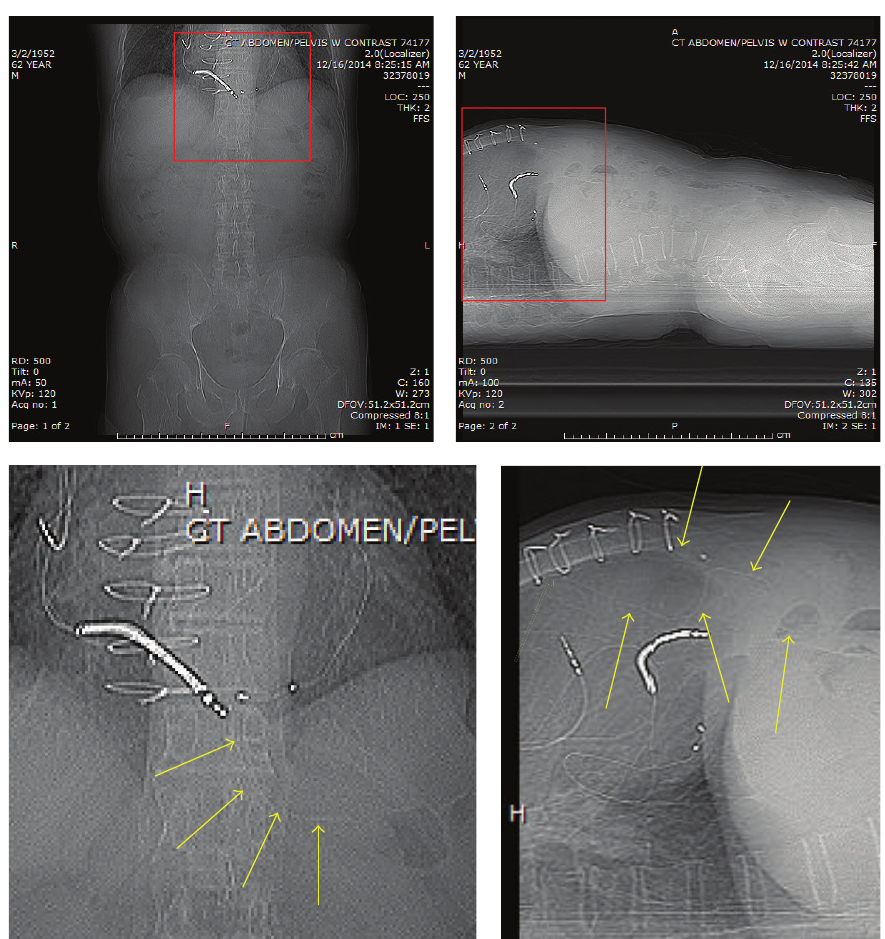
Figure 5: Scout images demonstrating faint linear hyperdensities (yellow arrows) vertically oriented descending below the diaphragm. The lateral scout view demonstrates the distal most aspect of the wires overlying air-filled transverse colon (found to be intraluminal on the following CT).